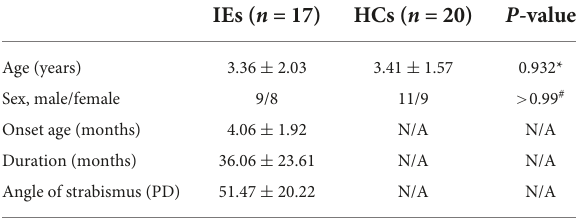
TABLE 1 Demographical and clinical features of study